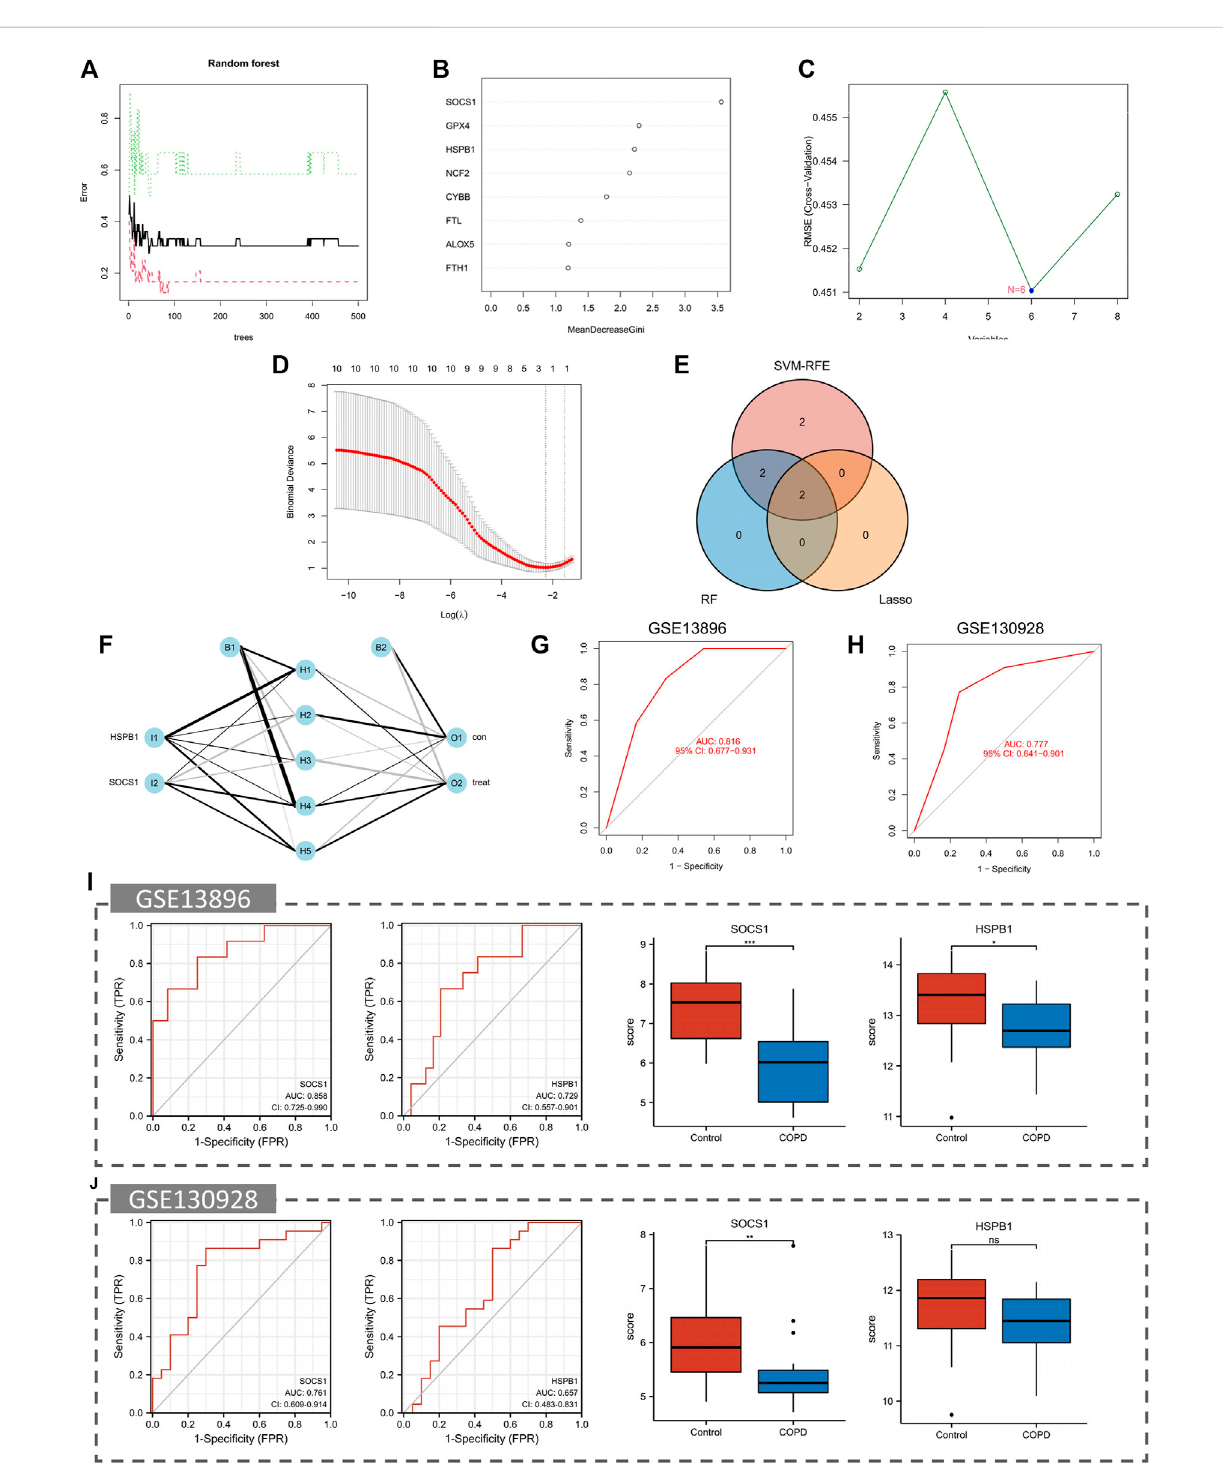
FIGURE 5 Identi fi cationandvalidationofthebiomarkers. (A,B) RFalgorithm. (C) SVM-RFEalgorithm. (D) LASSOregressionanalysis. (E) Vennplotexhibitingthe reliablebiomarkersamongLASSO,SVM-RFE,and RF. (F) The visualization oftheANNdiagnosticmodel. (G) The assessment resultofthedateset. (H) The testi fi cation result of the validation set. (I) Validation of the key crosstalk genes in GSE13896. (J) Validation of the key crosstalk genes in